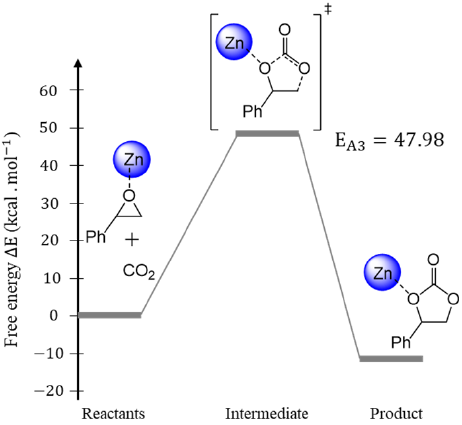
Figure 9. Free energy diagram (kcal/mol) of ZnI 2 catalyzed transformation of SO to SC.